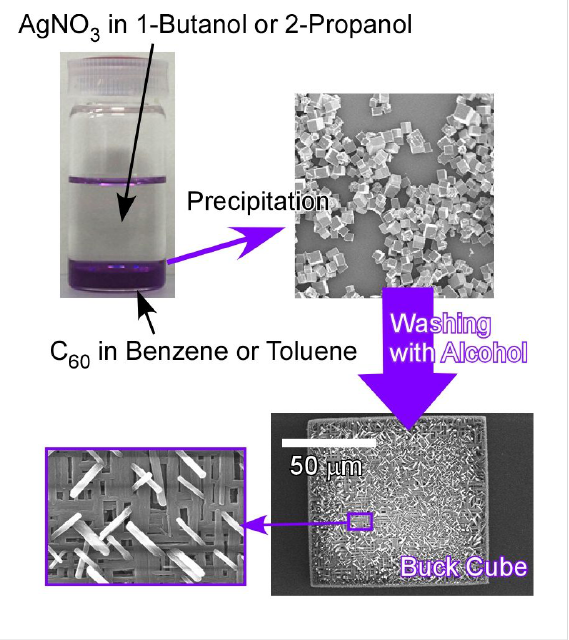
Figure 20: Highly integrated three-dimensional Bucky cubes synthe- sized by liquid–liquid interfacial precipitation of Olmstead's crystalline